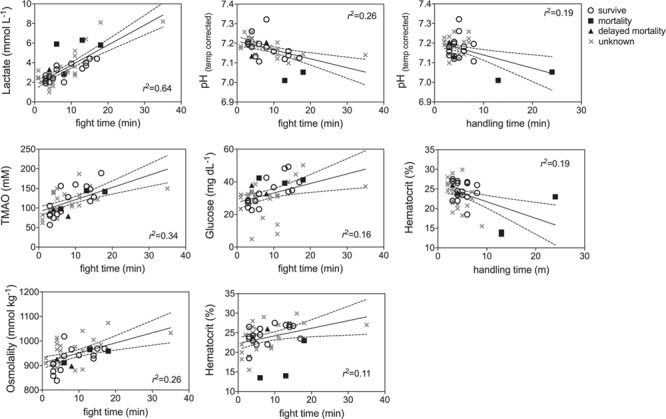
Linear regression plots of capture factors (fight time, handling time) that significantly affected blacktip blood chemistry (see Table 2 for parameter estimates) for survivors (open circle), mortalities (filled squares), delayed mortalities (filled triangle) and unknown (gray x) status.